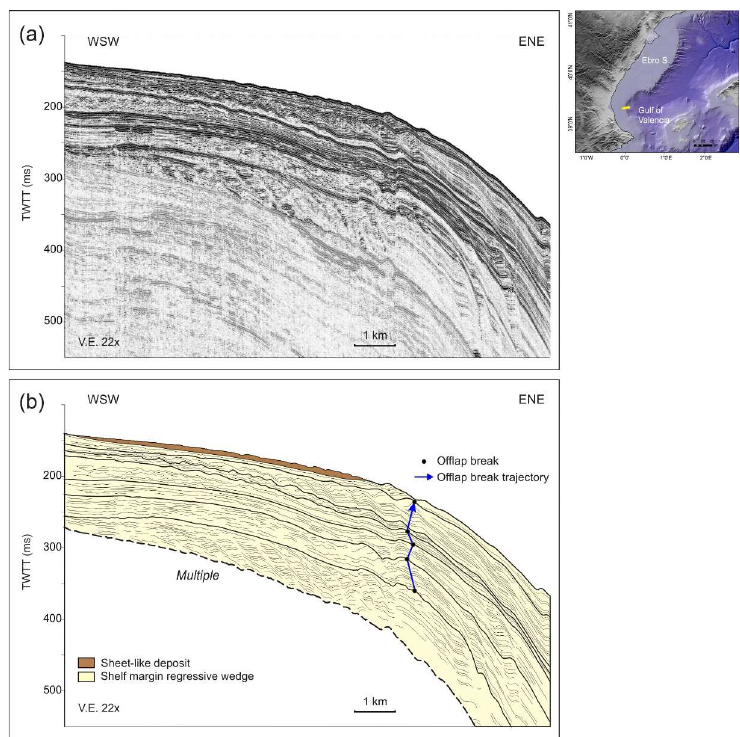
Figure 8. ( a ) Uninterpreted and ( b ) interpreted high-resolution Sparker seismic reflection profile of the shelf of the Gulf of Valencia. The upper Quaternary record is mainly composed of shelf-margin regressive wedges, with limited postglacial deposits. The shelf-edge trajectory was ascending (indeed, vertical). Modified from [10]. In the Northern Arc, the observed Quaternary record includes five depositional sequences mostly composed by shelf-margin regressive wedges that lead the margin outbuilt (Figure 9, Table 2). Geosciences 2018 , 8 , x FOR PEER REVIEW Over the different shelf breaks generated by the major regressive wedges, high-angle wedges are observed. A sheet-like deposit is only observed in the most recent depositional sequence. Sediment thickness of individual sequences on the shelf is variable between 25 and 50 ms TWTT. The progradation distance of the shelf ranges approximately between 23 and 27 km (Table 2), and the shelf-edge trajectory is mostly descending to flat, with a minor recent ascending interval (Figure 9).